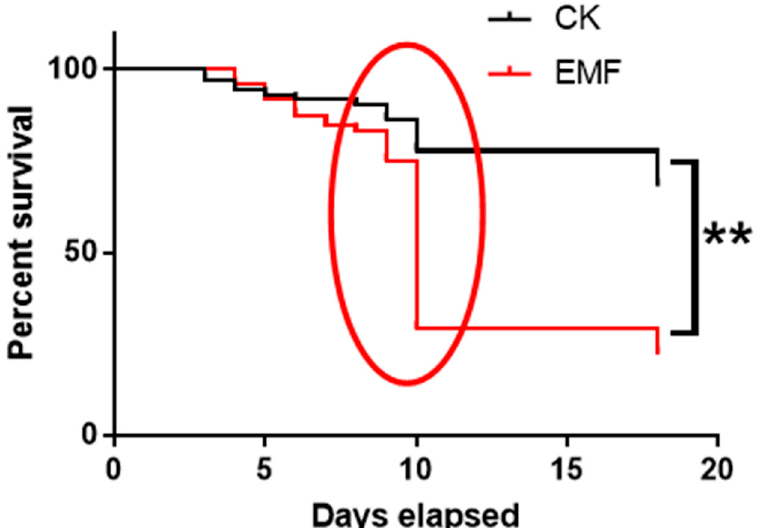
Figure 1. Effect of ELF-EMF exposure on the survival of A. cerana larvae. EMF: ELF-EMF exposed group (Red line). CK: Control group (Black line); Survival curves show ELF-EMF exposure significantly decreased the survivorship of honeybee larvae (Log-rank test, χ 2 = 28.24, p < 0.001), especially for the larvae in the process of metamorphosis and pupation (red line circled part). Note: ** means p < 0.01.